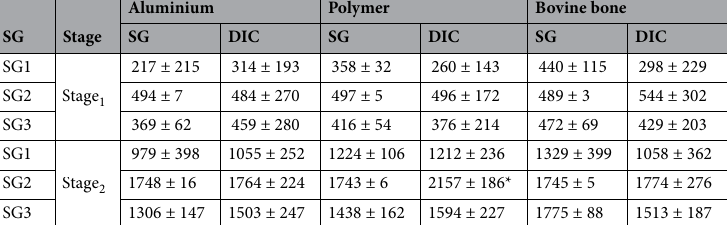
Table 1. Average strain measurements ± standard deviation for the DIC and SGs at the three SGs’ positions. All listed values are in μstrain. The standard deviation for the DIC measurements is the average of the different standard deviations for the measured specimens. *Indicates a significance difference in the mean.